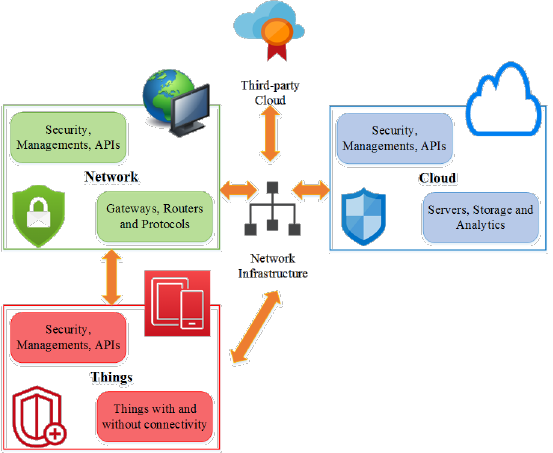
Figure 8. IoT architecture by